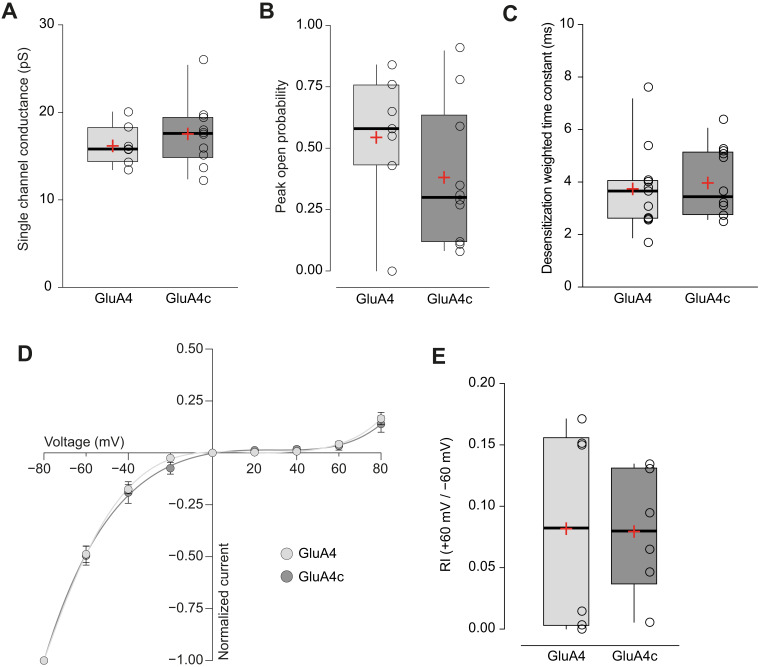
Short and long isoforms of GluA4 show the same electrophysiological behaviour.(A) Pooled data showing single channel conductance from GluA4 (light grey) and GluA4c (dark grey) homotetramers. Box-and-whiskers plots represent percentiles, median and average as stated in Figure 1c. (B) Data showing peak open probability from GluA4 and GluA4c tetramers. (C) Weighted time constant of desensitization (τw, des) from GluA4 and GluA4c tetramers. (D) Inwardly rectifying I-V relationships constructed from peak currents evoked by glutamate (100 ms, 10 mM) applied to outside-out patches from tsA201 cells containing GluA4 (light circle) or GluA4c (dark circle). Fittings are adjusted to a 6th order polynomial function. (E) RI (+60 mV /-60 mV) values from GluA4 and GluA4c tetramers. Data from this figure containing statistical tests applied, exact sample number, p values and details of replicates is available in ‘Figure 4—figure supplement 1—source data 1’.Figure 4—figure supplement 1—source data 1.Source data.